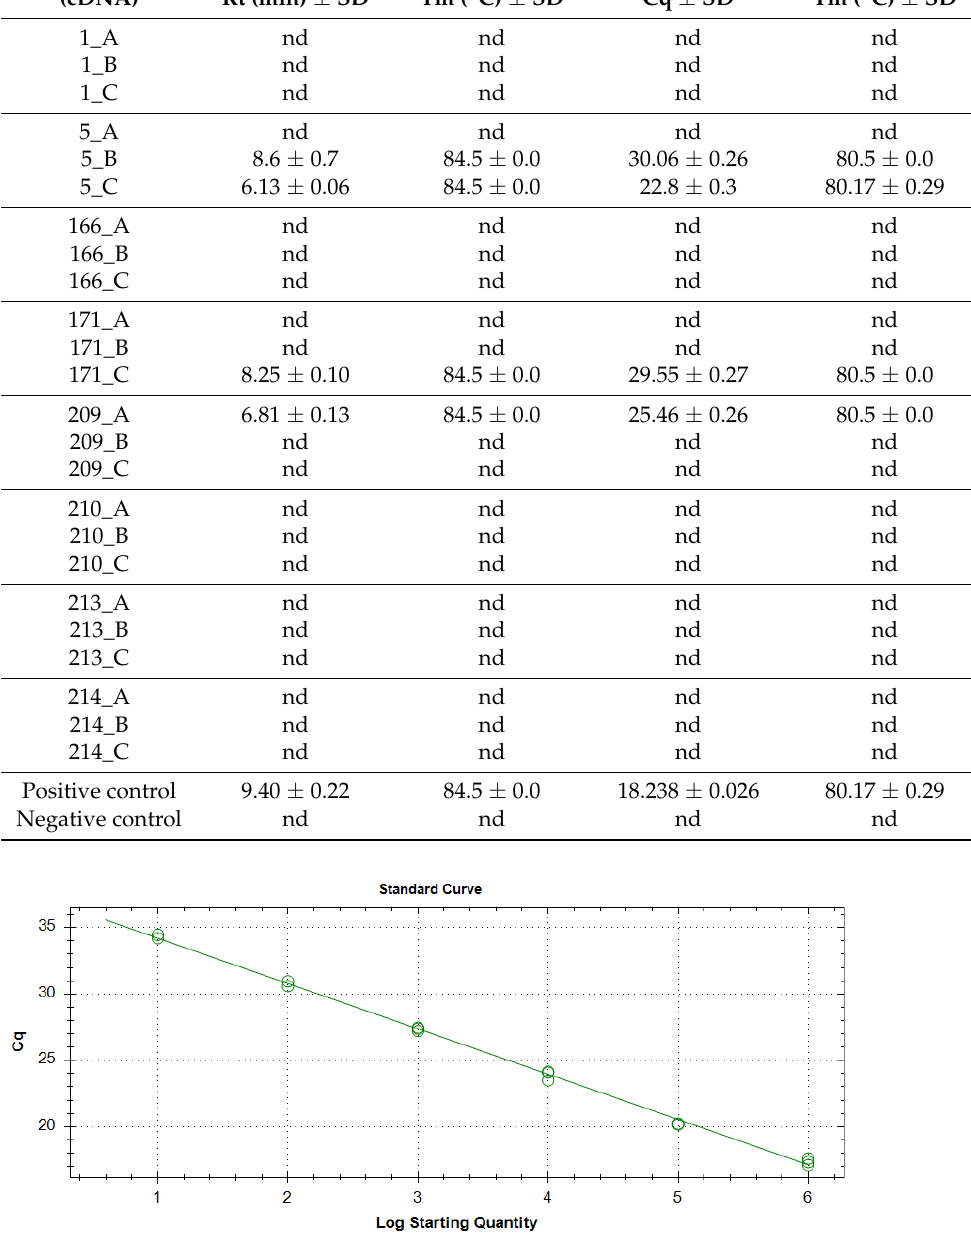
Figure 3. Standard curve obtained using 10-fold serial dilutions of linearized pSBCMV_6 plasmid. Experiment performed in the CFX instrument.